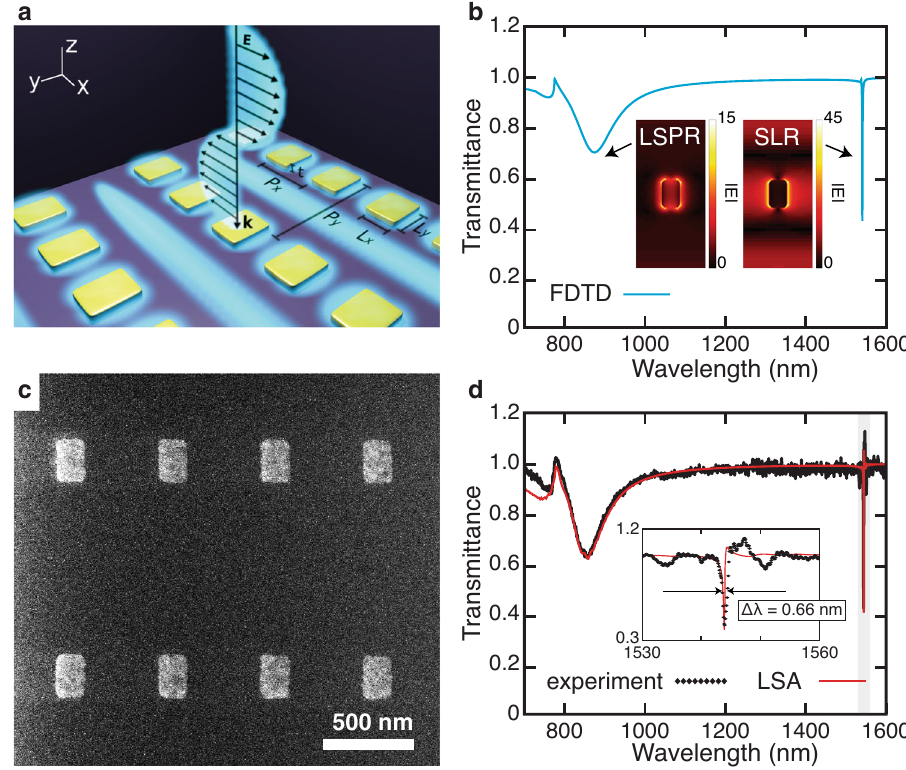
Fig. 1 High- Q metasurface nanocavities using arrays of plasmonic nanostructures. a Schematic of the metasurface consisting of a rectangular array of rectangular gold nanostructures. Here L x = 130 nm, L y = 200 nm, t = 20 nm, P x = 500 nm, and P y = 1060 nm. The blue shaded regions illustrate the electric fi eld, reproducing the mode structure in the inset of b . b Numerical (FDTD) calculations of the transmission spectrum of this metasurface for x -polarized light. Both the LSPR and the SLR are observed in these results. Inset: The simulated magnitude of the electric fi eld ∣ E ∣ for the entire unit cell of both LSPR and SLR modes in the x – y plane that bisects the nanoparticles. The color bar indicates the relative magnitude when normalized to the incident plane wave. c Helium ion microscopic image of the fabricated metasurface prior to cladding deposition. d Measured transmission spectrum (black dots) and fi ts to semi-analytic calculations (LSA, red line). Inset: Zoomed plot of the highlighted region in d . Fitting the measurement to a Lorentzian function yields a linewidth of Δ λ = 0.66 nm, corresponding to Q = 2340 (see Supplementary Sec. S1: Q -factor